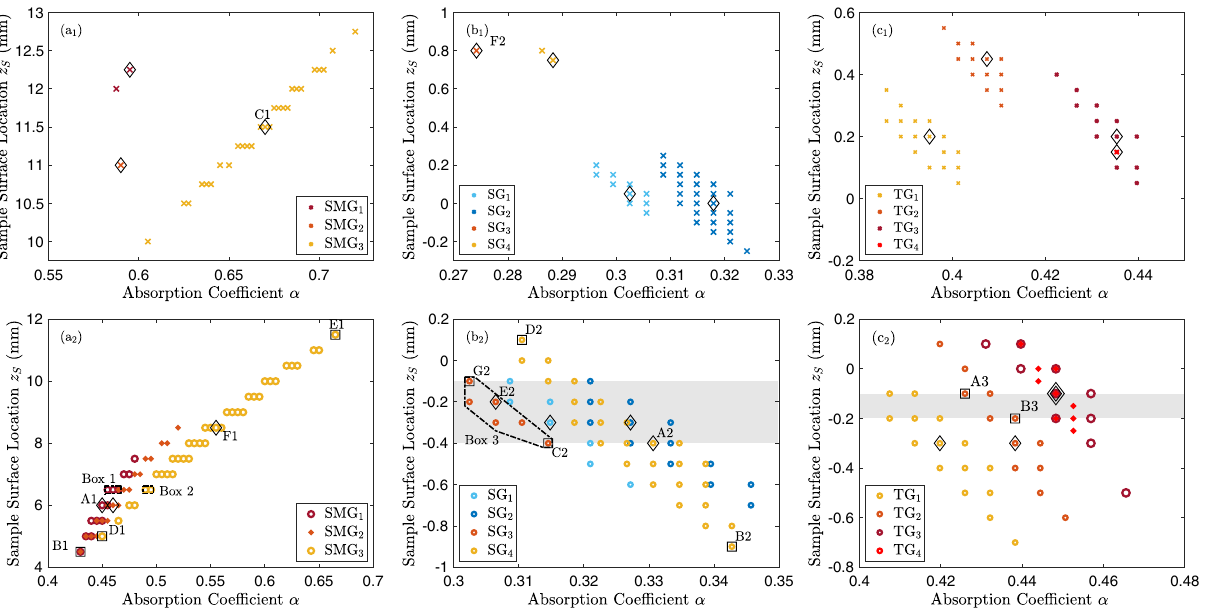
Figure 3. Pairs (α , z S ) that generate 2D melt pool traces with an error smaller than the error threshold in Table 1 for each experiment, out of a large set of sampled pairs. Top row: conductive model. Bottom row: convective model. The grayed region indicates the range of sample surface locations common to all experiments in the SG and TG groups. No common set of values was found with the conductive model, despite the fact that experiments in the SG and TG group were all performed at the same sample surface location. Larger error thresholds of 1.2 µ m instead of 1 µ m and 5.5 µ m instead of 5 µ m had to be selected for the SG 4 and SMG 2 cases, respectively, to find at least one pair with the conductive model. Some (α , z S ) values are labeled (e.g. B2) or boxed to be referenced elsewhere, and optimal values in Table 1 for each experiment are indicated with diamonds.